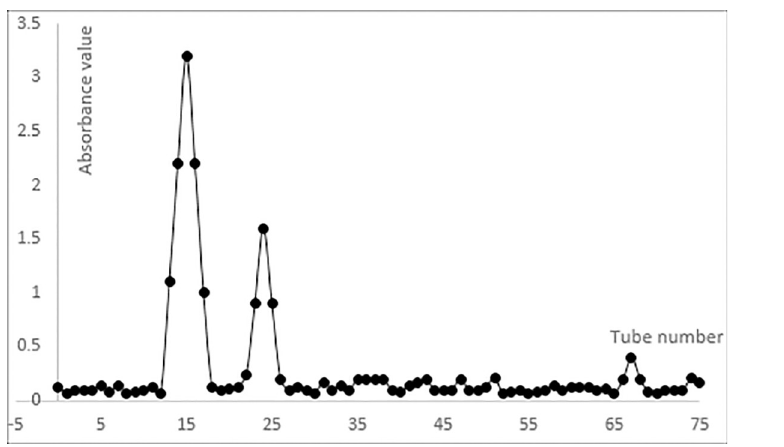
Fig 5. Linear elution of pure